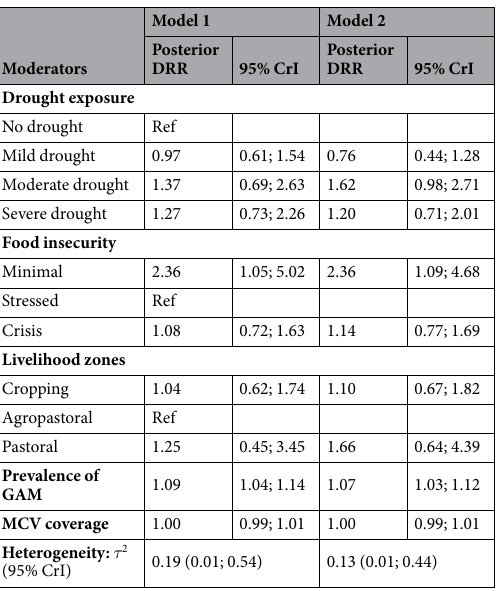
Table 2. Results from a Bayesian Poisson meta-regression models of small-scale mortality surveys from Ethiopia, 2009–2014. Model 1 investigates the effect of short-term droughts on child mortality, whereas Model 2 investigates the effect of long-term droughts on child mortality, both adjusted for survey-specific moderators (food insecurity, livelihood zones, prevalence of GAM, and MCV coverage). The prevalence of GAM was calculated based on the weight for height z-score index 34 . The MCV coverage was based on vaccination cards and/or caregiver’s recall. The statistical significance is based on the non-inclusion of 1.0 in the 95% CrI. DRR: death rate ratios; CrI: credible interval; Ref: reference